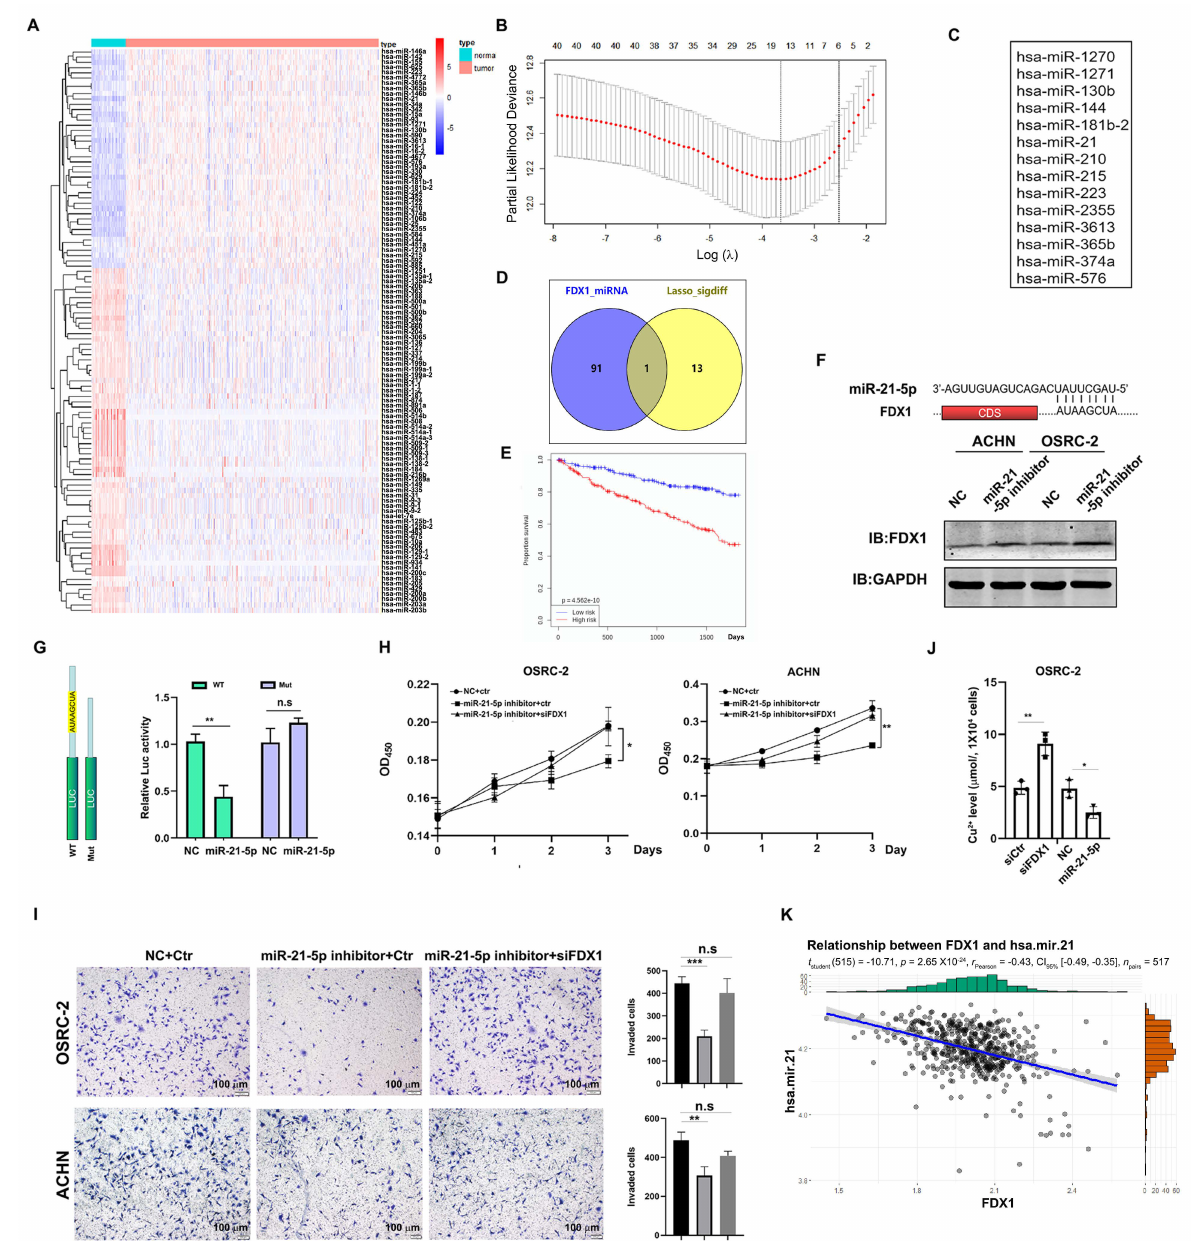
Figure 6. Identification of miR-21-5p as the upstream regulator of FDX1. ( A ) A heap map of miRNAs differentially expressed between normal kidney tissues and ccRCC. ( B ) Prognosis-based LASSO analysis of the differential miRNAs. ( C ) A list of 14 miRNAs highly related to the prognosis. ( D ) A Venn diagram of 14 miRNAs and FDX1-targeted miRNAs. ( E ) High expression of miR- 21-5p was associated with a short overall survival of ccRCC. ( F ) Top, the predicted binding site between the 3 (cid:48) -UTR of FDX1 and miR-21-5p. Bottom, miR-21-5p inhibitor treatment elevated FDX1 expression in both ACHN and OSRC-2 cells. GAPDH was the loading control. ( G ) Luciferase report assay showed that miR-21-5p mimics remarkably suppressed the activity of 3 (cid:48) -UTR of FDX1. ( H ) miR-21-5p inhibitor-suppressed cell growth of ACHN and OSRC-2 cells could be rescued by FDX1 knockdown. ( I ) miR-21-5p inhibitor-suppressed cell invasion of OSRC-2 cells could be blocked by FDX1 knockdown. Left, representative invading cells. Right, statistical analysis. Scale bar = 100 µ m. ( J ) Cu 2+ level in OSRC-2 cells before and after miR-21-5p inhibitor or siFDX1 treatment. ( K ) miR-21-5p expression was inversely correlated with FDX1 in TCGA-KIRC. * p < 0.05, ** p < 0.01, *** p < 0.001; n.s. = no